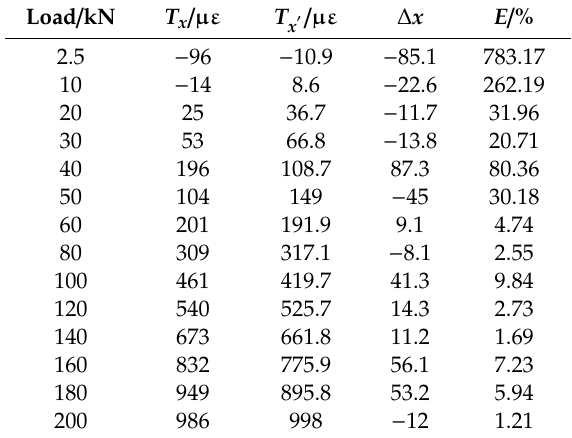
Table 2. Comparison of Process A Distributed Optical Fiber and MTS Test